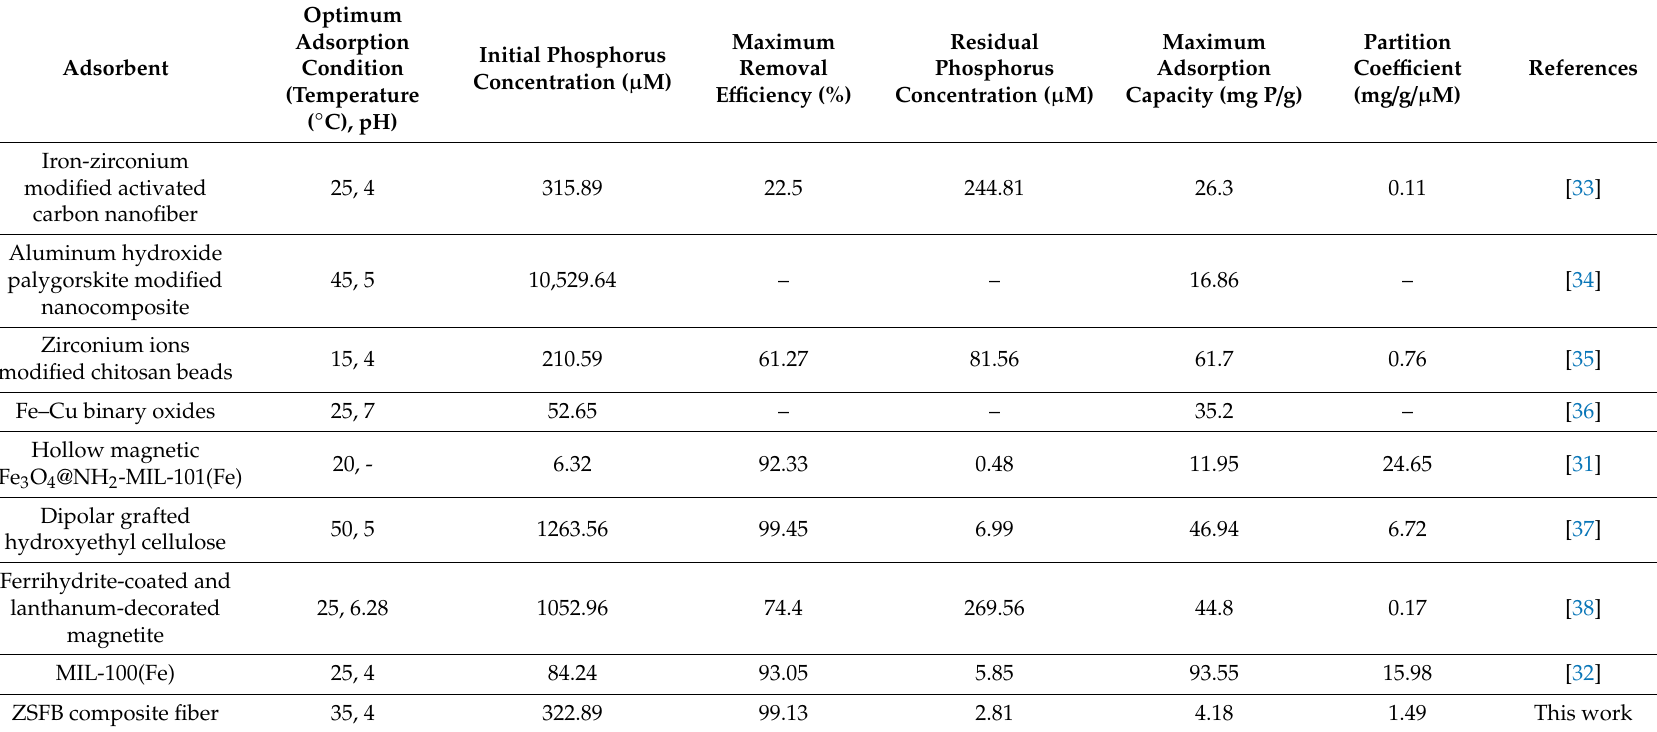
Table 9. Performance of di ff erent adsorbents for adsorptive removal of phosphorus from aqueous